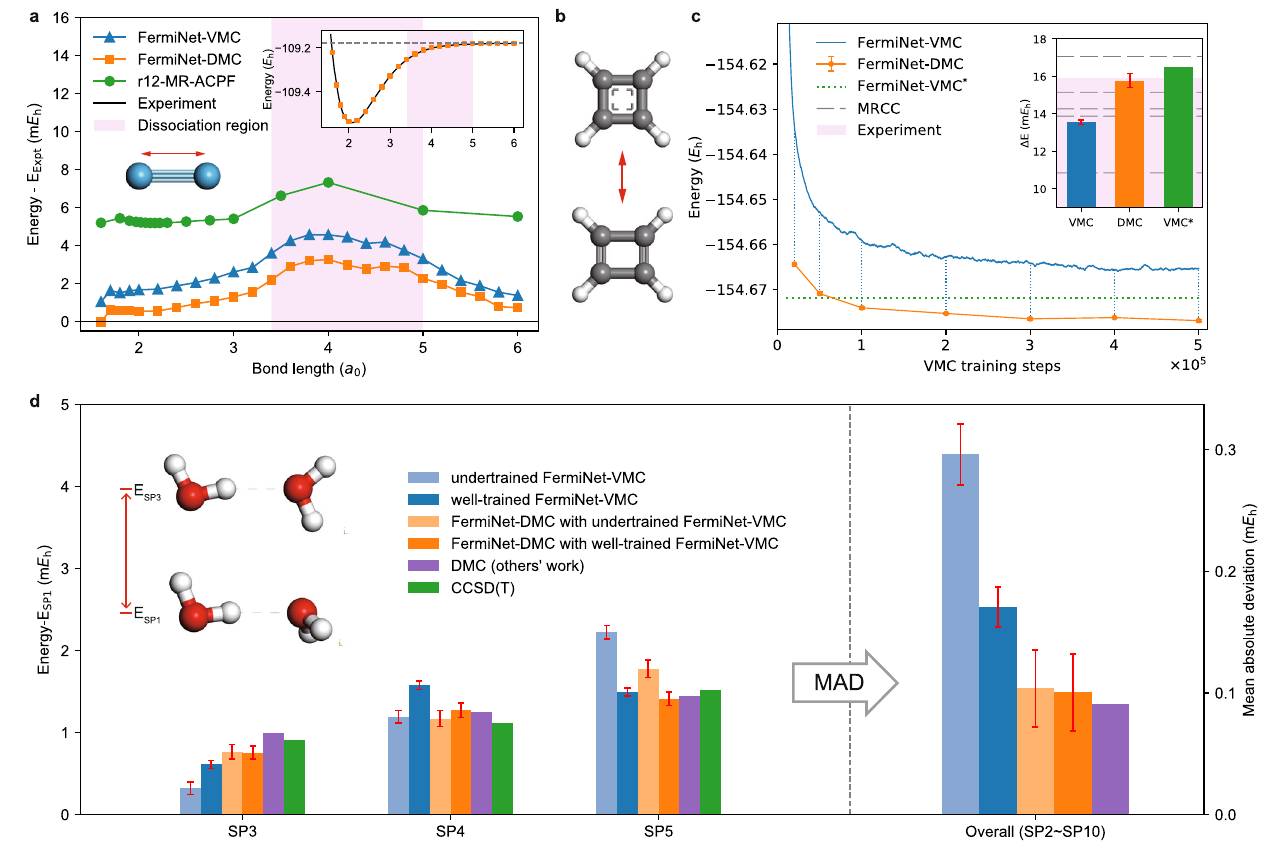
Fig. 3 | Calculations on N 2 , cyclobutadiene, and water dimer. a Main panel: calculated energy of N 2 at different bond length, plotted as the difference to the experimental data 29 . For comparison, the green line is the highly accurate r12-MR- ACPF results under a modi fi ed basis set based on aug-cc-pV5Z 30 . Inset: the dis- sociation curves from experimental data (black line) and FermiNet-DMC (orange squares). The negligible error bars (less than 0.1mHa) are not plotted. The pink backgrounds highlight the dissociation region where correlations are strong. b Molecular structures of cyclobutadiene ’ s equilibrium state (bottom) and transi- tion state (top). c Main panel: the ground state energy of cyclobutadiene ’ s equili- brium state as a function of the VMC training step. FermiNet-DMC energy is calculated using the trial wavefunction at the corresponding training steps. FermiNet-VMC * indicatestheresultfromSpenceretal. 21 .Inset:thetransitionbarrier of cyclobutadiene calculated with different methods. Pink background indicates therangeofexperimentalestimatesbetween2.5and15.9mHa,whileweshowonly